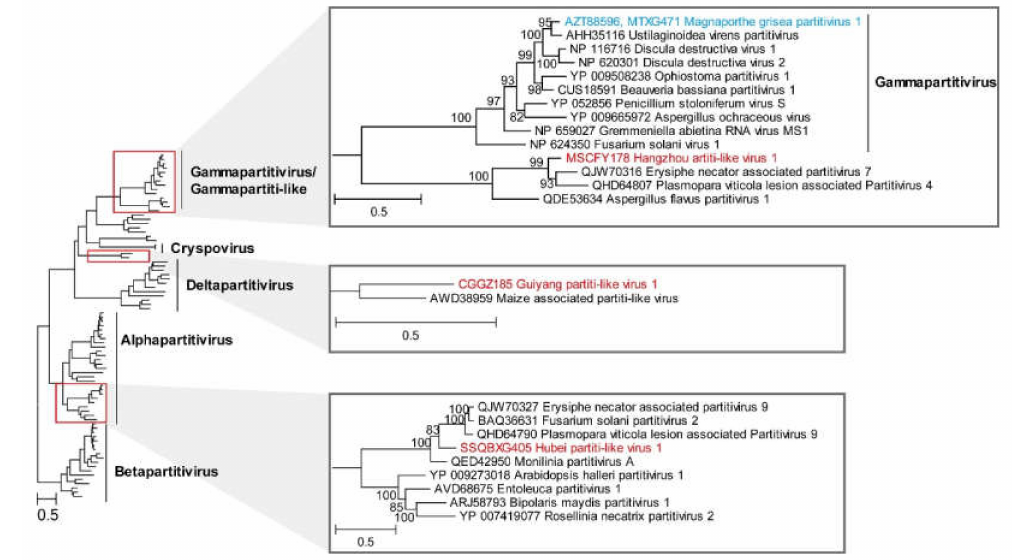
Figure 6. ML phylogenetic analysis of the family Partitiviridae . Phylogenetic trees were constructed using the aligned sequences of RdRp. The names of new viruses discovered in this study are marked in red, the names of known viruses discovered in this study are marked in blue, the reference virus serial numbers and names are marked in black and the genera of viruses (and branches in minimized trees) in this study are marked in bold. The red box represents the clade of the virus identified in this study. The grey triangle represents the enlarged part of the red